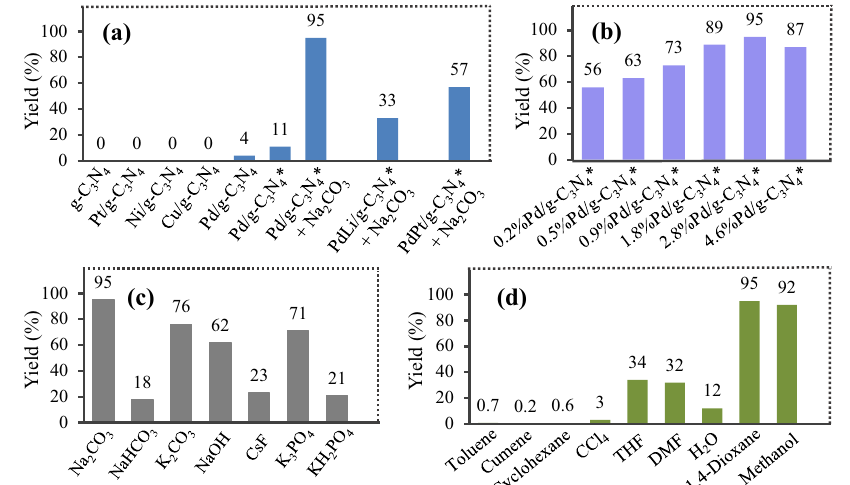
Fig.3|Effectofdifferentconditionsonthecouplingofbromobenzene.a Effect ofdifferentphotocatalystsystems.Theloadingofthemetalong-C 3 N 4 is2.8wt%in allcases.M/g-C 3 N 4 :graphitephasecarbonnitride-supportedmetal,M/g-C 3 N 4 *:the activated Pd/g-C 3 N 4 by the light-irradiated treatment. b Effect of different Pd loading amounts. x%Pd/g-C 3 N 4 * means that the loading of Pd on g-C 3 N 4 is x wt%.